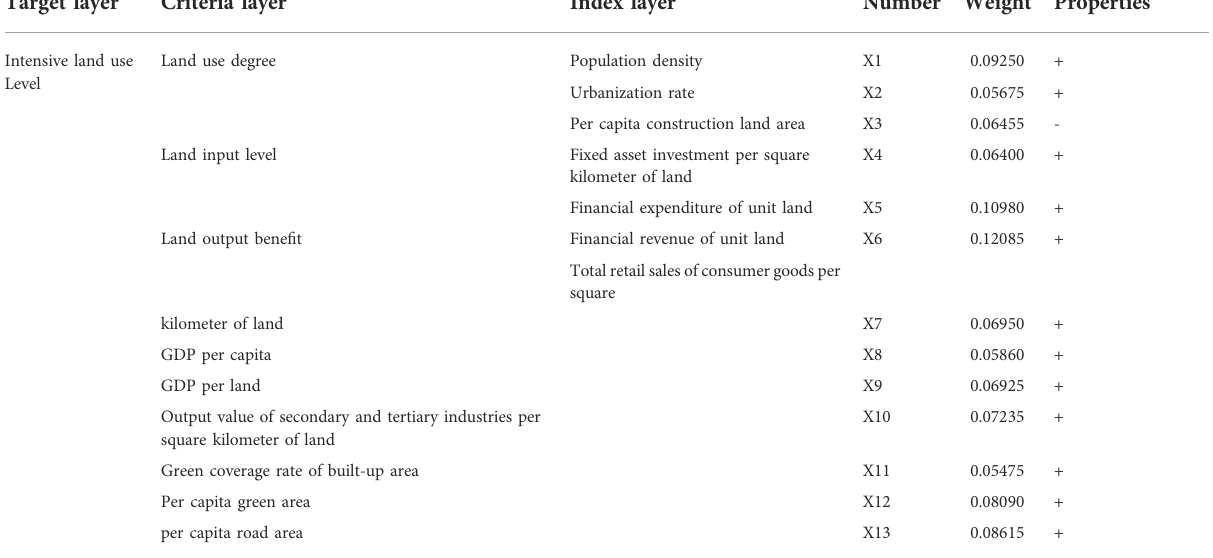
TABLE 1 Indicator system for intensive land